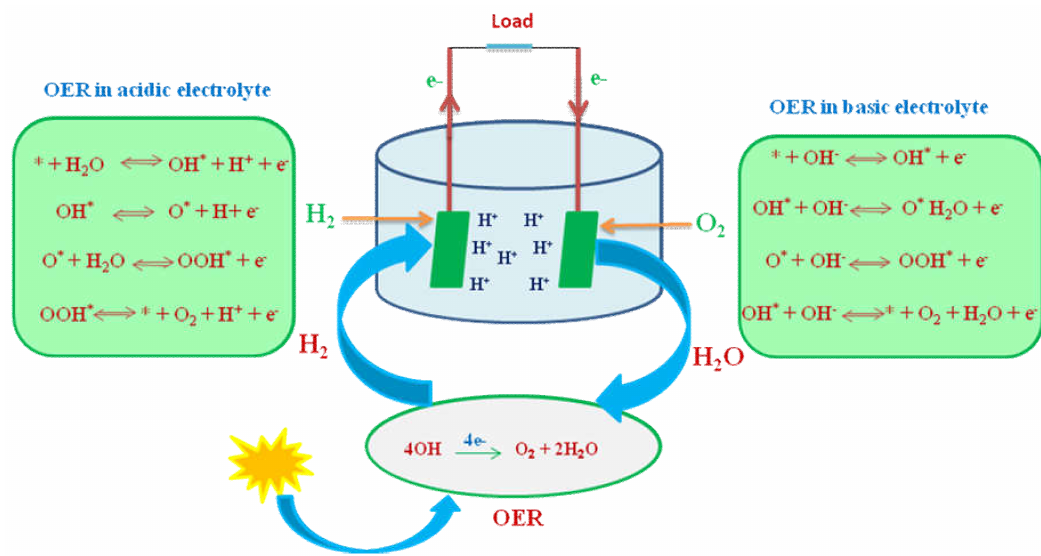
denoted by the symbol * in the above